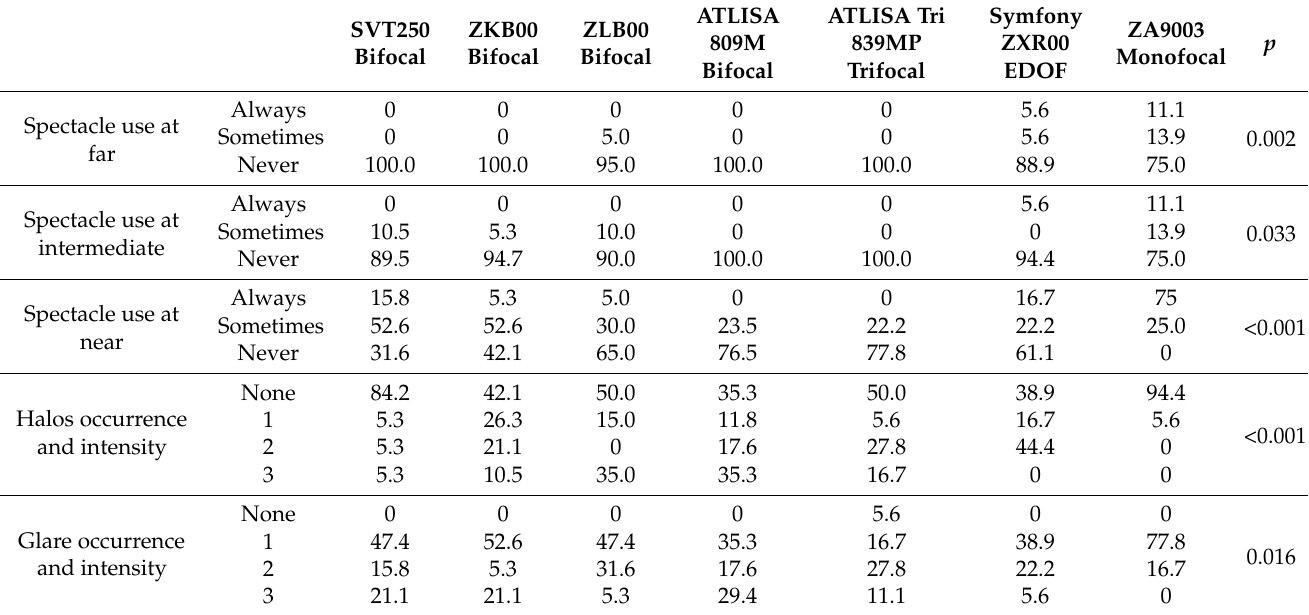
Table 4. Quality of vision for each lens type and results of the Kruskal–Wallis test of statistical significance ( p -value). All results are percentage of